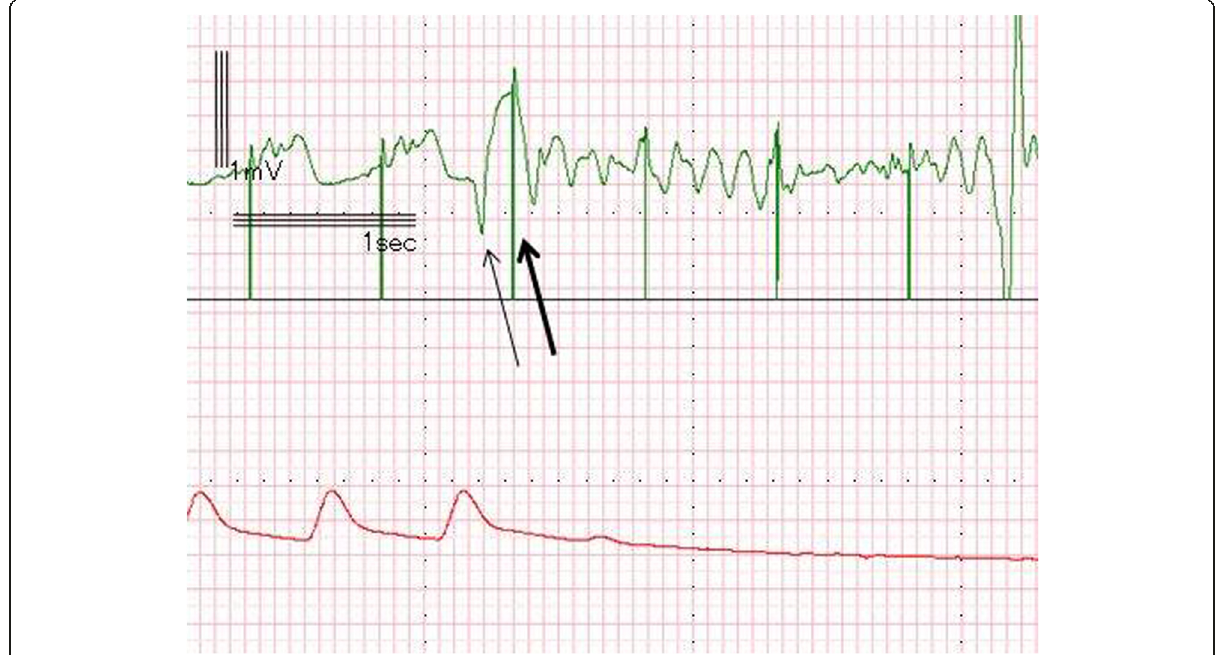
Fig. 4 ECG and pressure waveform during the second episode of ventricular fibrillation. This ECG also shows the R-on-T phenomenon resulting from undersensing of a PVC. A pacing spike hit the T wave (large arrow) following a PVC (small arrow) in this episode, as